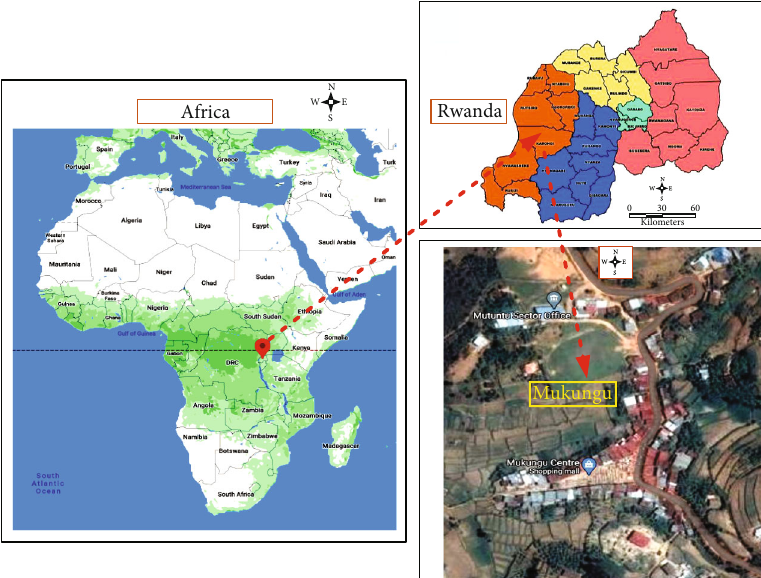
Figure 15: Map of the selected location study area.